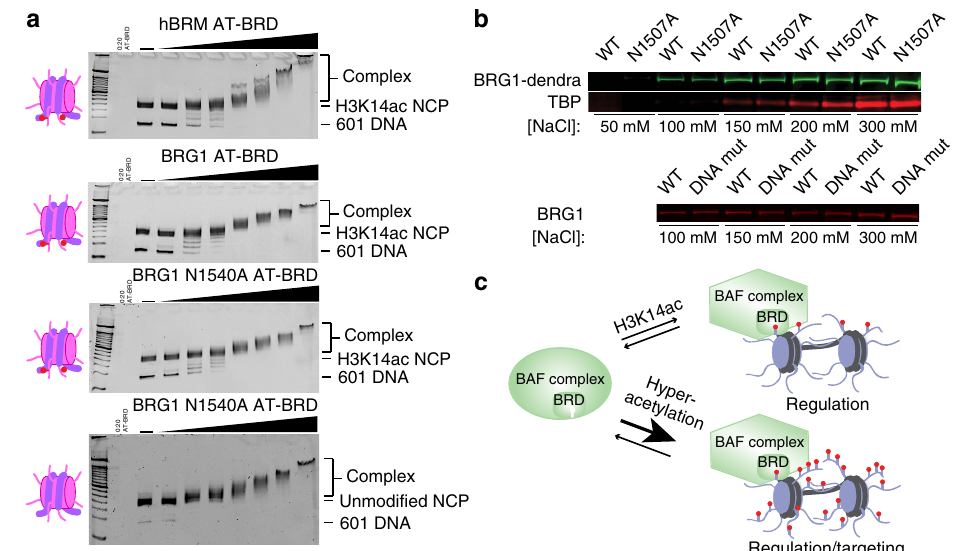
Figure 6 | Association with H3K14ac does not contribute to nucleosome association. ( a ) EMSAs carried out with the hBRM AT-BRD or the BRG1 wild- type or N1540A mutant AT-BRD with either the unmodified NCP or the H3K14ac-NCP. Gels were run with a 100bp DNA ladder in the far left lane and stained with ethidium bromide for visualization. ( b , top) Differential salt extraction of chromatin-associated proteins from wild-type BRG1-Dendra2 heterozygous mouse ESCs (WT) and BRG1(N1507A)-Dendra2 heterozygous mouse ESCs (N1507A). Wild-type BRG1 and BRG1(N1507A) were detected via blotting of the C-terminal Dendra2 protein tag, with TBP detection serving as loading control. (bottom) Differential salt extraction of chromatin- associated proteins from parental TC1 ESCs (WT) and BRG1 K1508D,K1509N,K1518A-GFP homozygous mouse ESCs (DNAmut). The blot displays BRG1 contained in the free nuclear-supernatant fraction after salt extraction, detected by the G7 anti-BRG1 antibody. ( c ) Proposed model for the role of BRG1/hBRM BRD in the context of the BAF complex in response to acetylation. Upon specific recognition of H3K14ac, BRG1/hBRM BRD causes a change in the BAF complex that regulatesBAF function. Under conditions of hyper-acetylation, the high concentration of even weak binding sites could mean that the BRG1/hBRM BRD additionally plays a role in targeting or